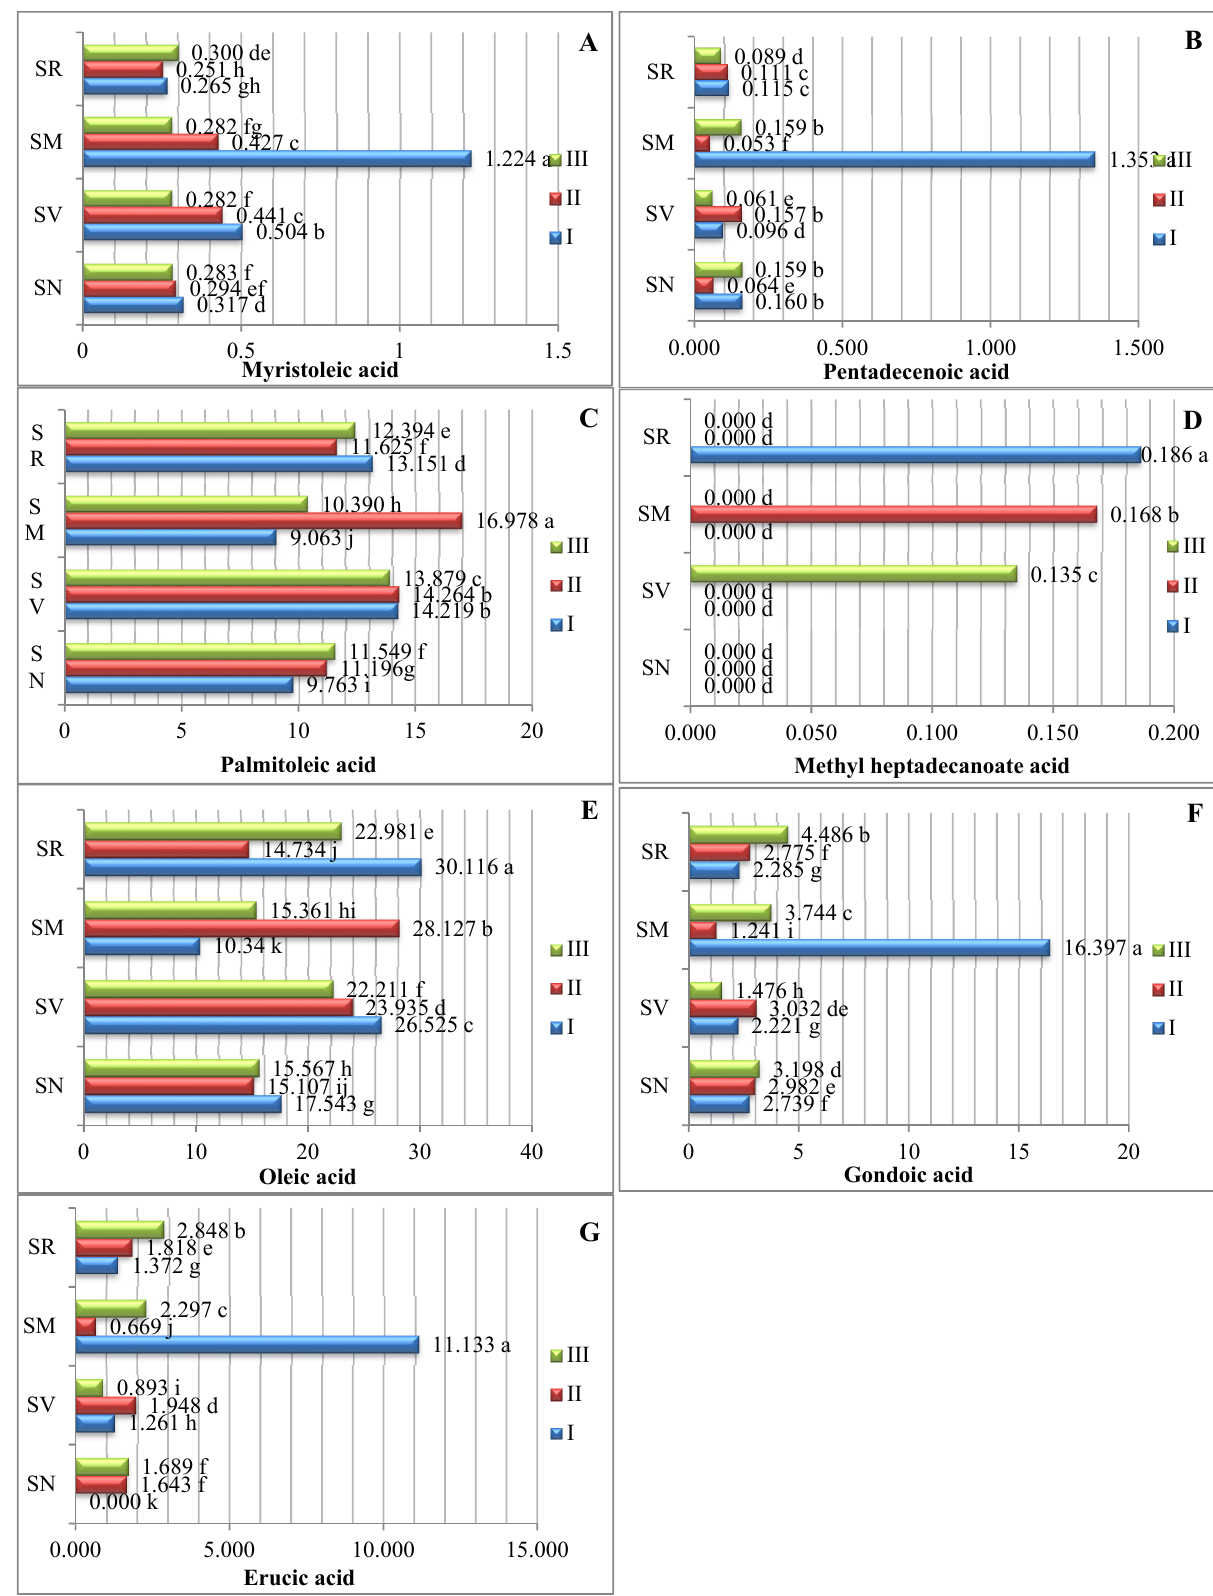
Figure 2. Amounts of monounsaturated fatty acids in Solanum spp. fruit, %, in different ripening stages. Note: Percentages followed by different letters are statistically different ( p < 0.05); S. retroflexum – (SR), S. melanocerasum –(SM), S. nigrum –(SN), S. villosum –(SV); ripening stages I, II,